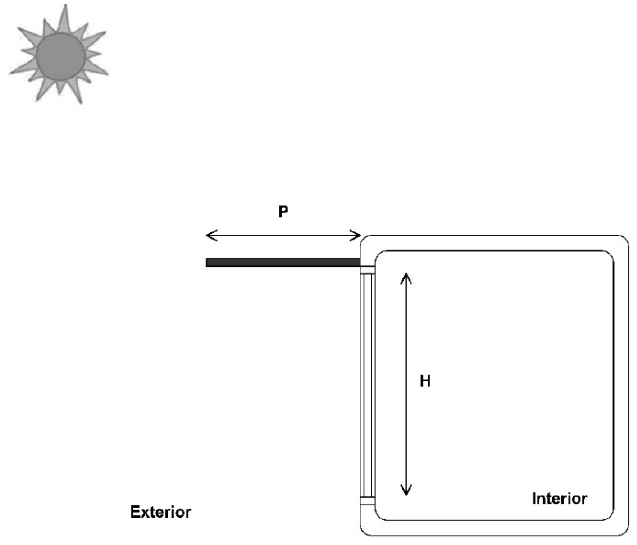
Figure 1. Length of horizontal